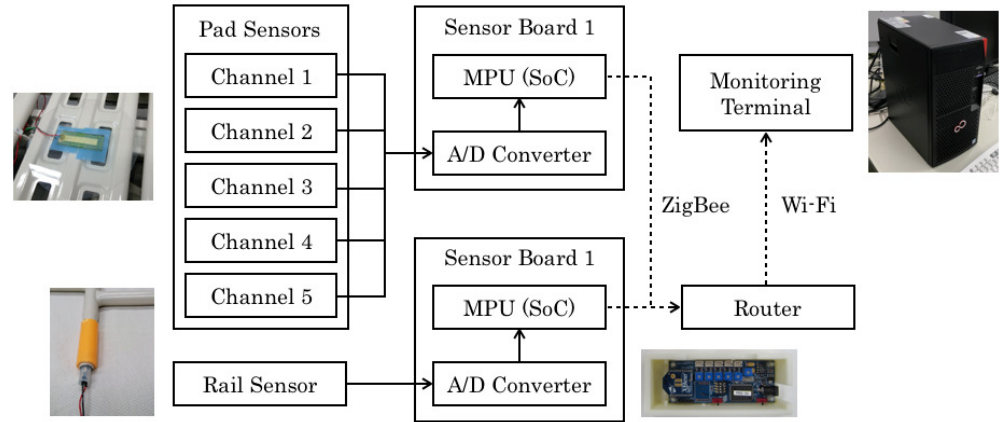
Figure 1. Whole system